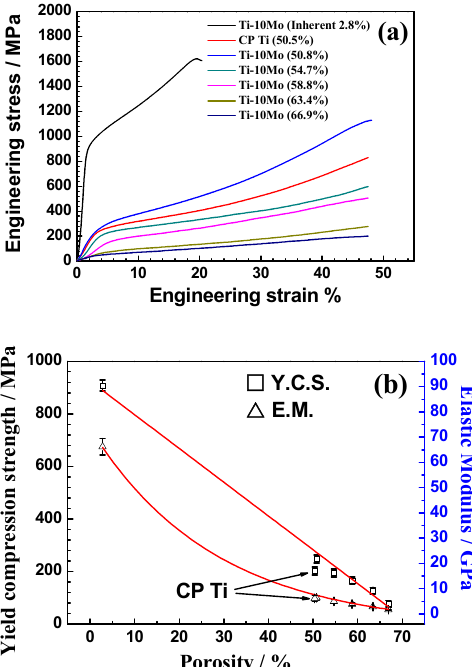
Figure 6. ( a ) Engineering Stress-strain curves of different Ti alloy samples ( b ) Influence of porosity on compression yield strength and elastic modulus mechanical properties of porous